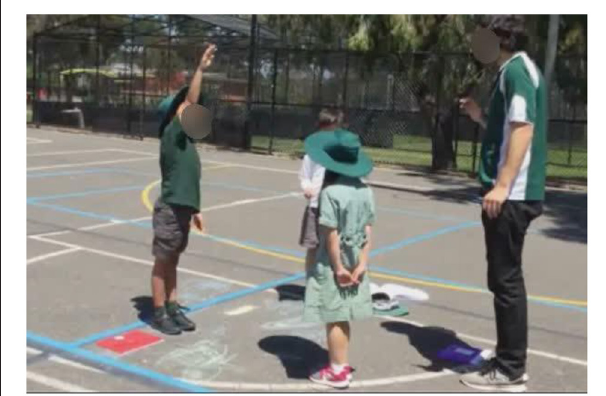
FIGURE 1 | Colin creating sign systems to mark the sun’s position in the sky and on the 2D schoolground surface.